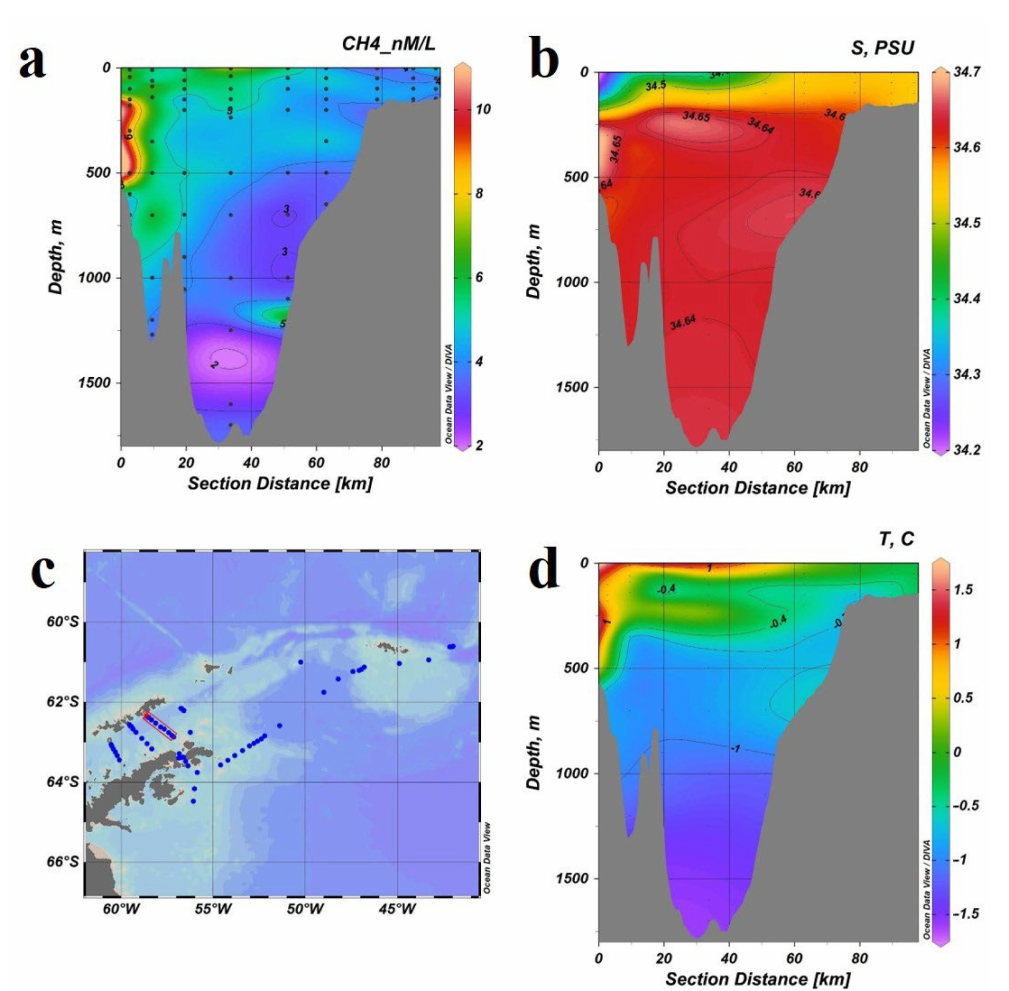
Figure 4. Distribution of methane concentration ( a ), temperature ( d ) and salinity ( b ) in the eastern section ( c ) in the Bransfield Strait.